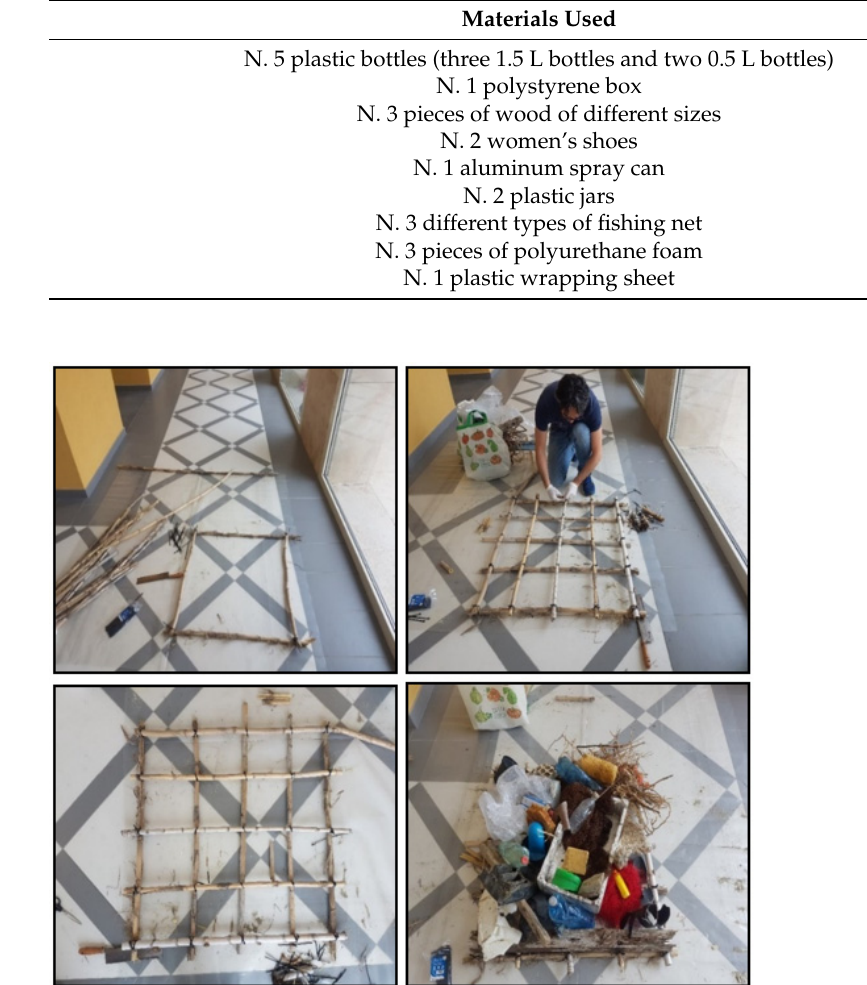
Figure 4. Assembly phases of the basic SGI module.